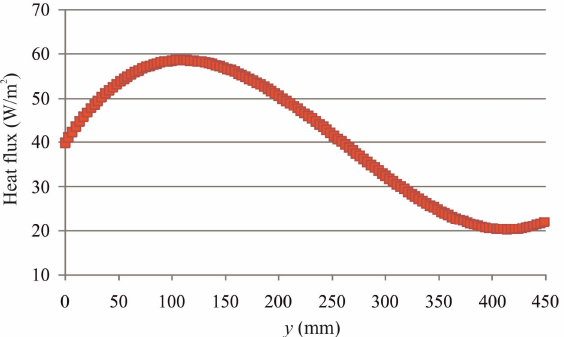
Fig.7. The heat flux transferred to cabin of the vehicle.